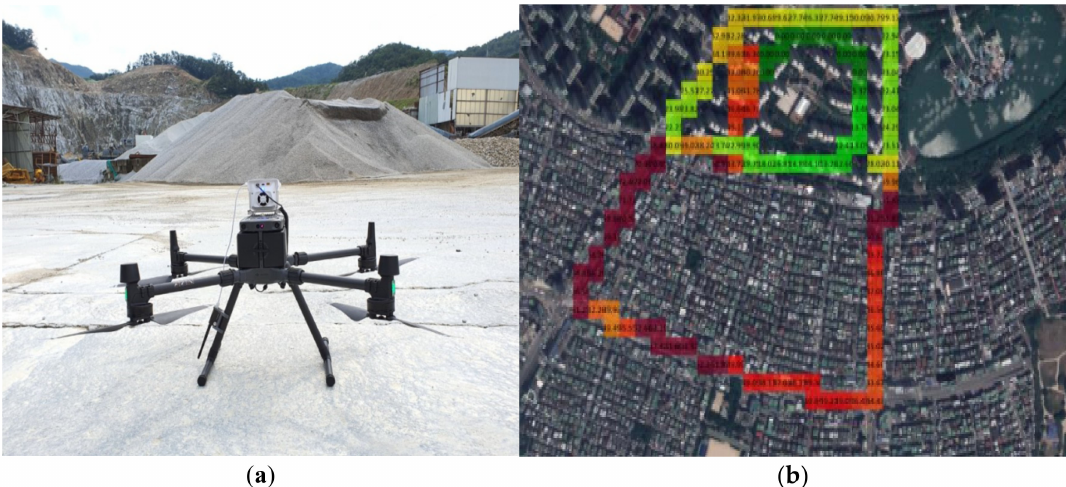
Figure 2. Measurement of the fine particulate matter (PM) concentration using a Sniffer4D module. ( a ) UAV with sniffer 4D; ( b ) 2D maps for data analyzed in Sniffer4D